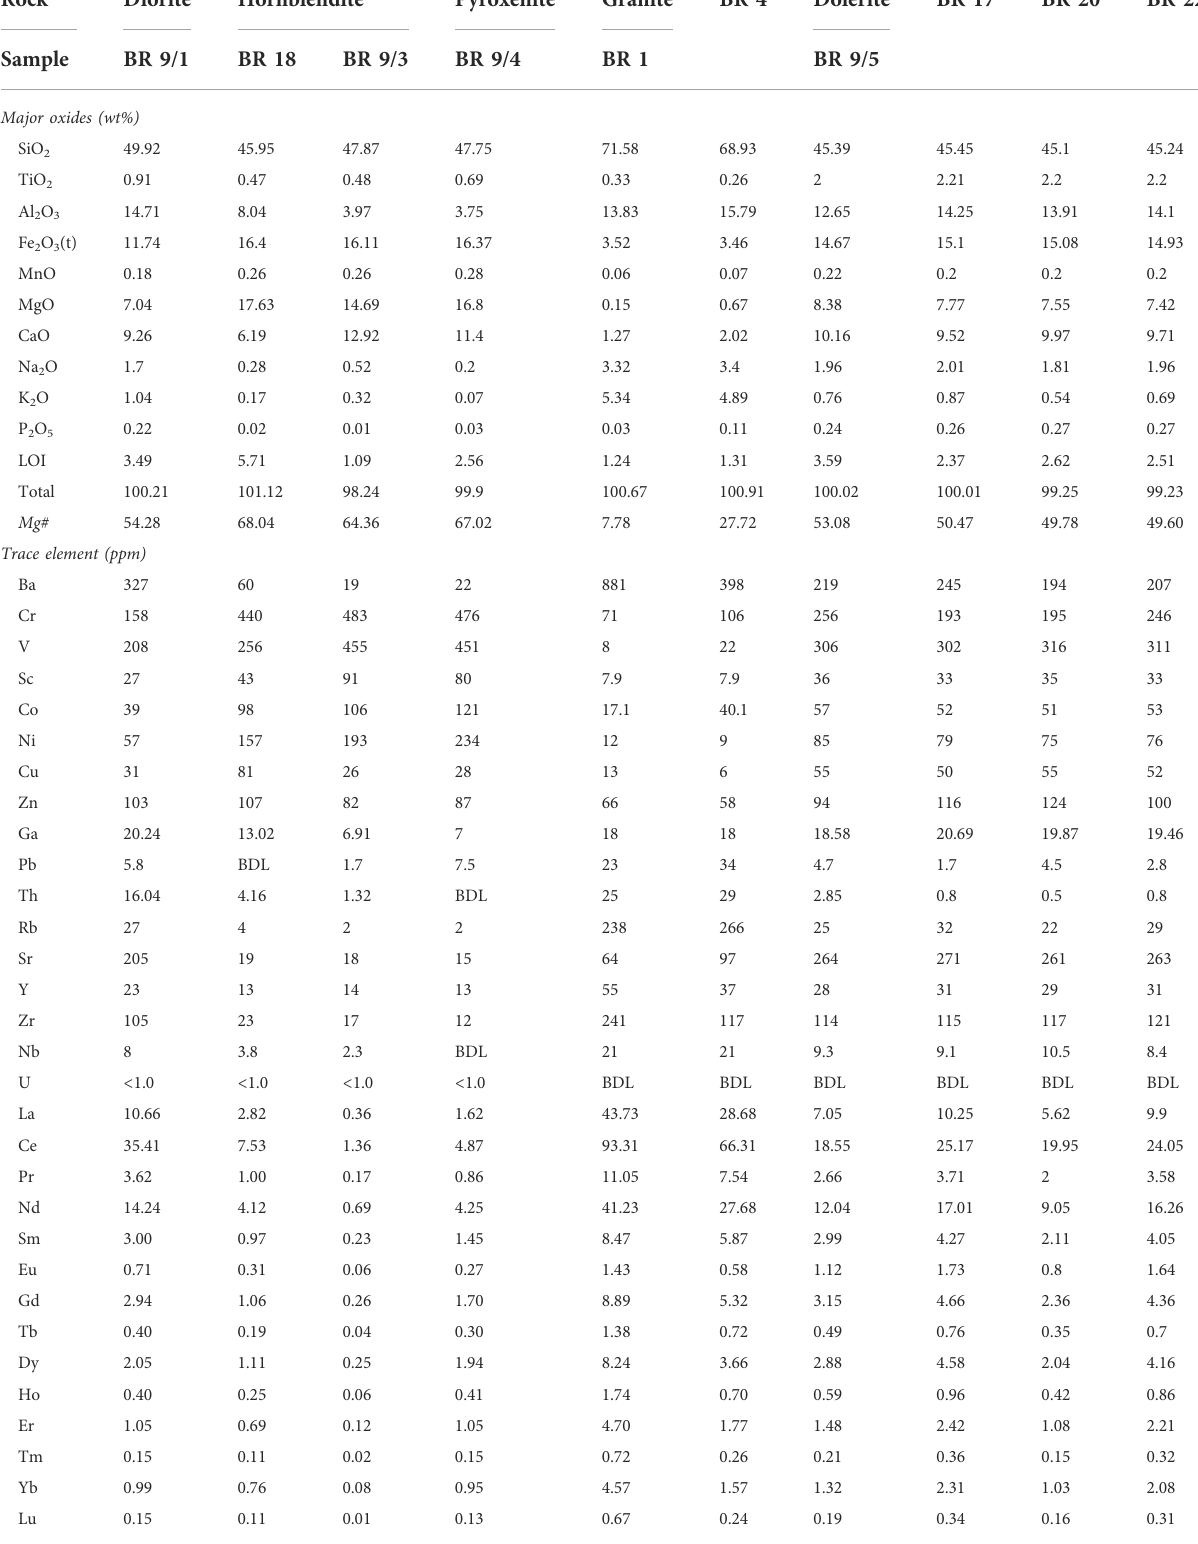
TABLE 2 Whole-rock composition of the studied diorite, hornblendite, pyroxenite, granite, and dolerite samples from the Chotanagpur Granite Gneiss Complex via X-ray fl uorescence spectrometer and inductively coupled plasma mass spectrometer. Rock Diorite Hornblendite Pyroxenite Granite BR 4 Dolerite